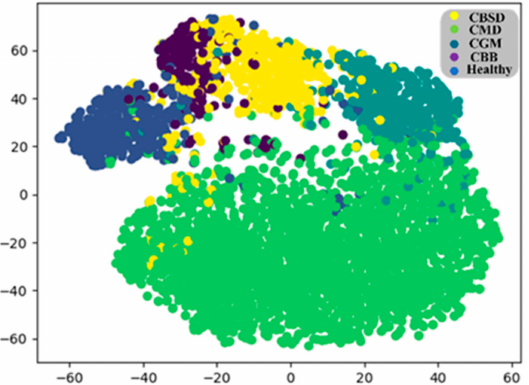
Figure 10. Visualization of the penultimate layer features of the T-RNet model using